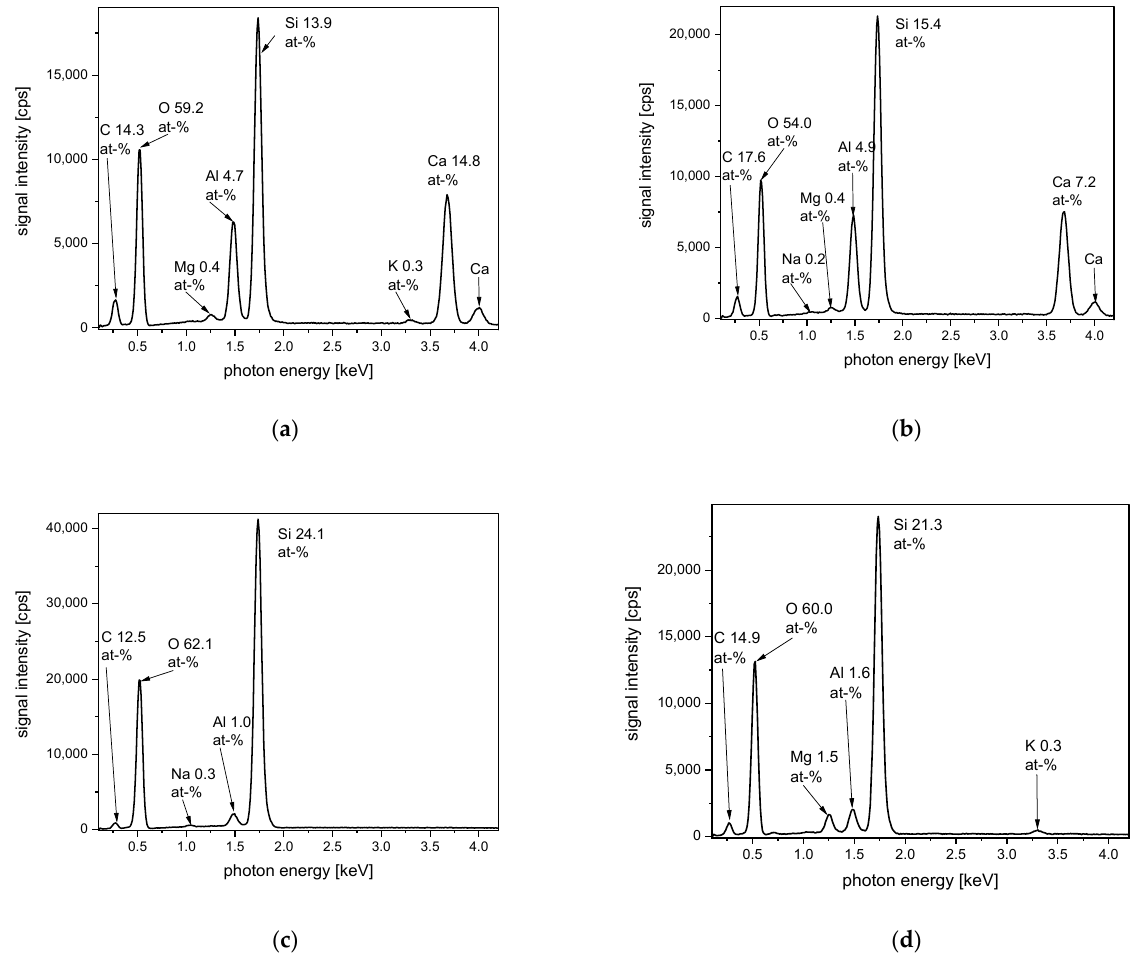
Figure 29. EDS spectra of different glass and silica fiber fabrics supplied by Culimeta: ( a ) e-glass fabric; ( b ) caramelized glass fabric; ( c ) silica fabric; ( d ) glass fabric modified with vermiculite particles.